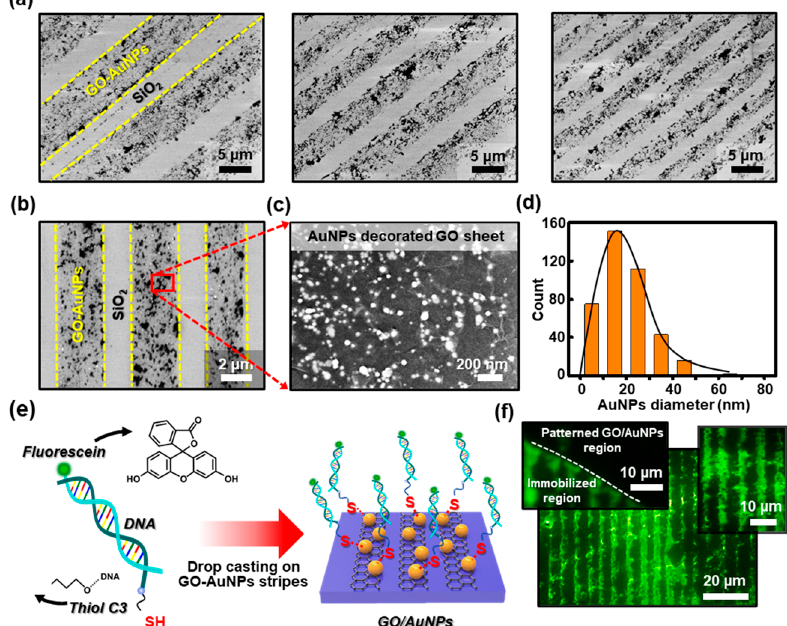
Figure 4. ( a ) A set of scanning electron microscopy (SEM) images collected from the di ff erent locations, presenting close-packed arrays of GO / AuNP stripes formed on a substrate in a gradient fashion. ( b ) A representative SEM image of the stripe patterned GO / AuNPs arrays configured with sharp contrast. ( c ) A highly magnified SEM image of densely embedded AuNPs in GO sheets, corresponding to the surface of the marked area shown in ( b ). ( d ) Histogram of the diameter of the